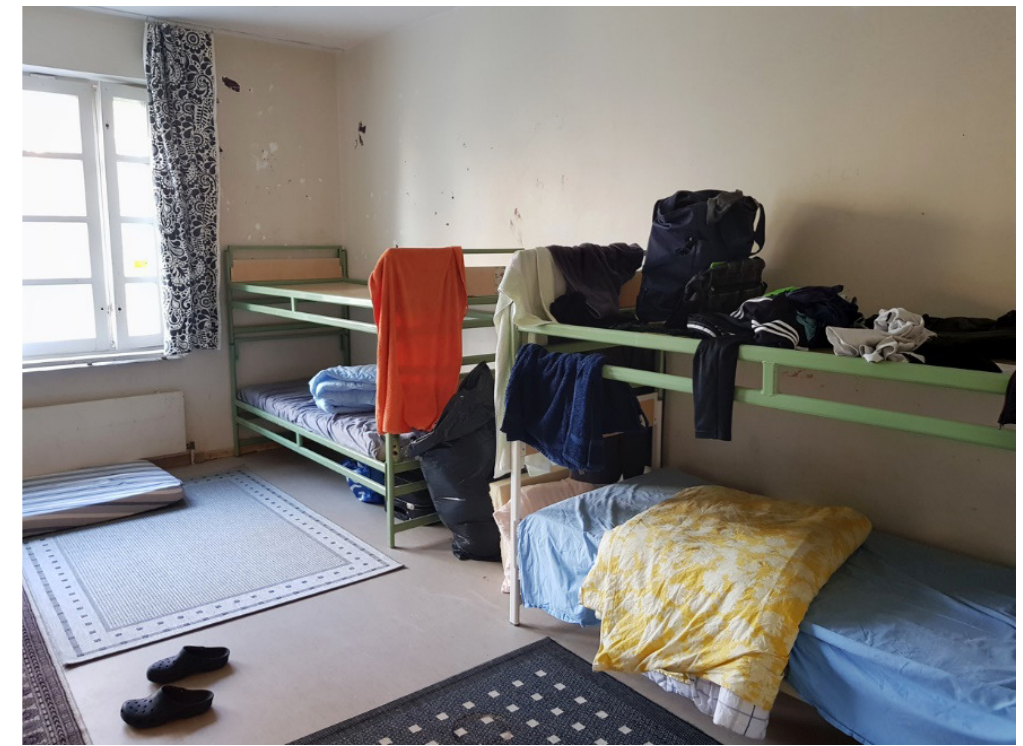
Figure 3. I am here